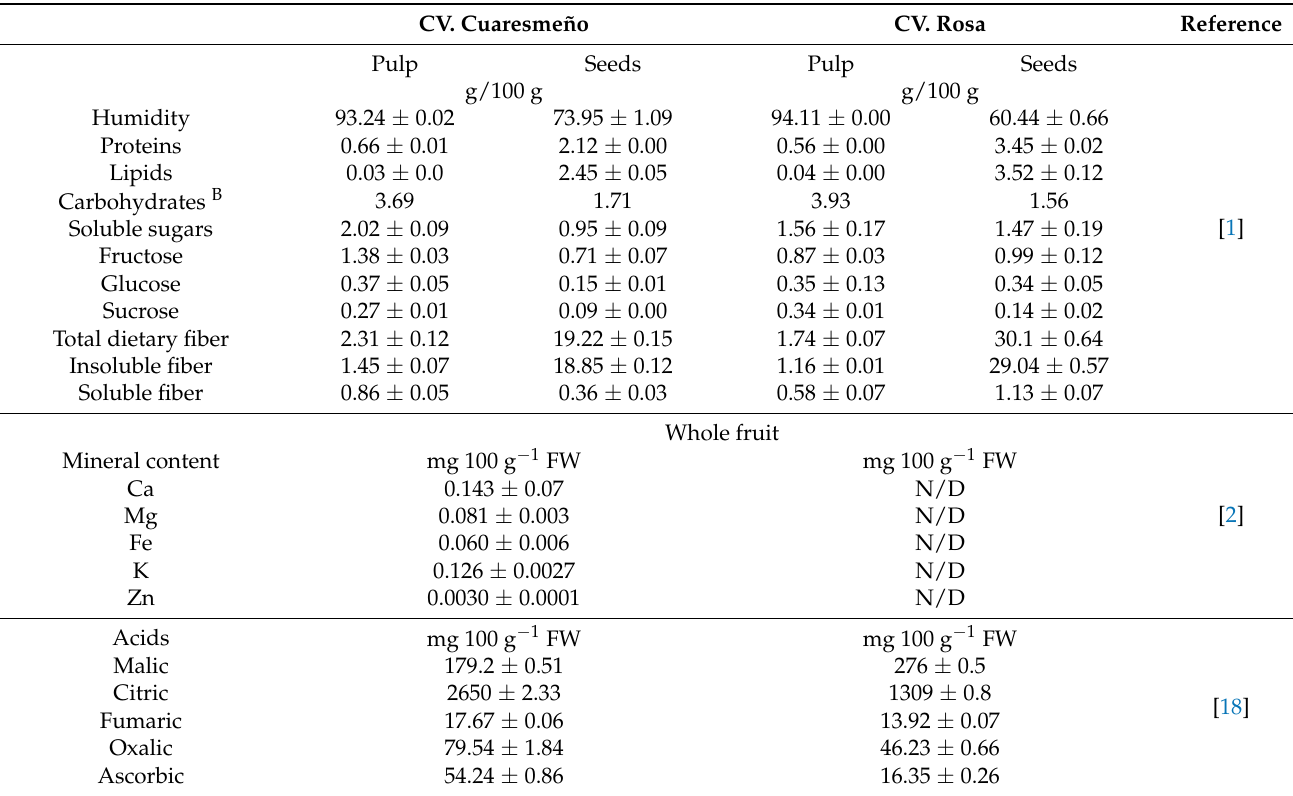
Table 1. Chemical composition of two varieties of xoconostle ( Opuntia